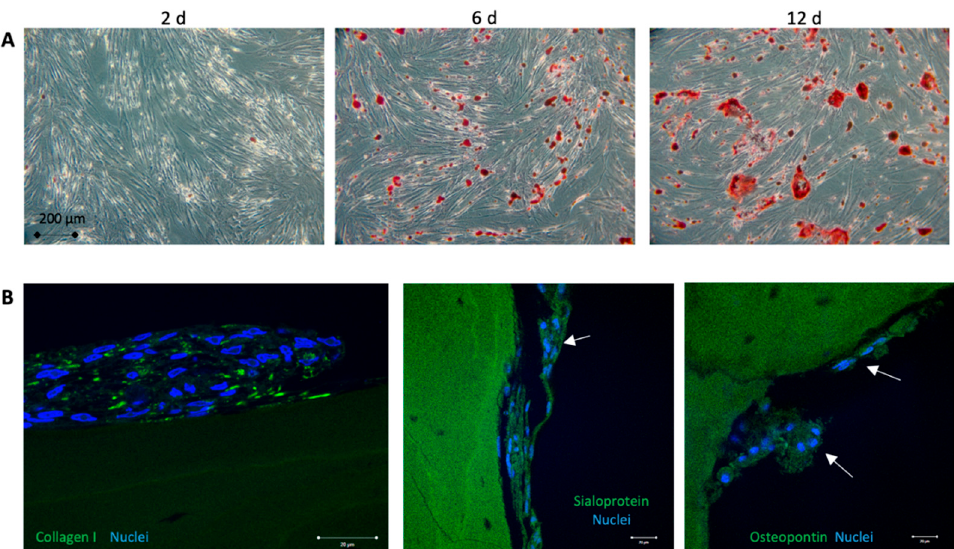
Figure 2. Proof of osteogenic differentiation. ( A ): Osteogenic differentiation of the adiopose-derived stem cells was monitored by Alizarin red staining to identify calcium deposits in a time series. All isolated stem cells were able to differentiate into osteoblasts in time range of 20–30 days. ( B ): Immunohistological staining of the osteogenesis markers collagen I, sialoprotein and osteopontin (green fluorescence) counterstained with Hoechst (blue) to label the nuclei of the adiopose-derived stem cells after 2 weeks. In the undifferentiated control group, no expression markers were seen.